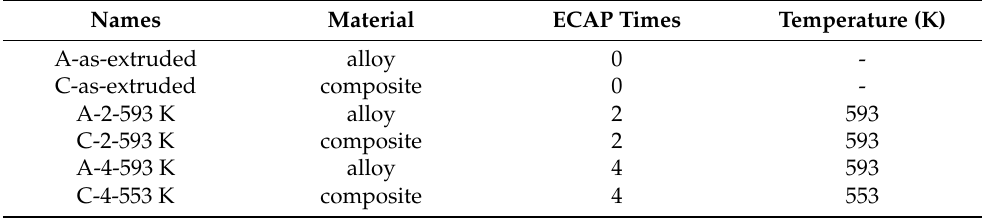
Table 1. ECAP processing parameters used in this study.